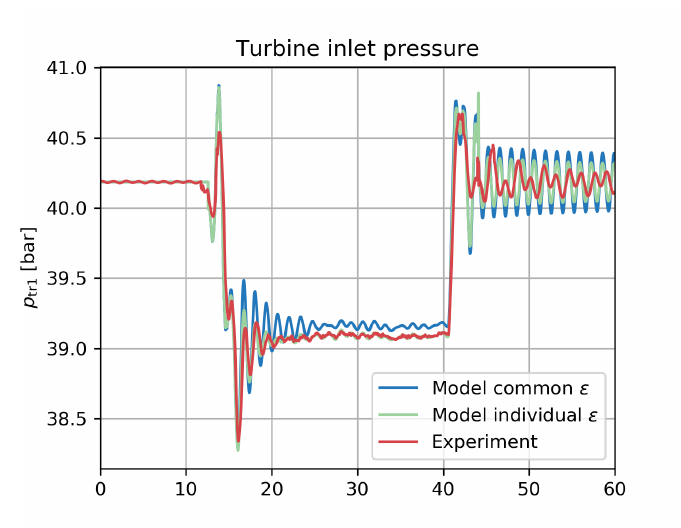
Figure 7. Comparison of the turbine inlet pressure from the simple model simulations with individual ε settings and experimental